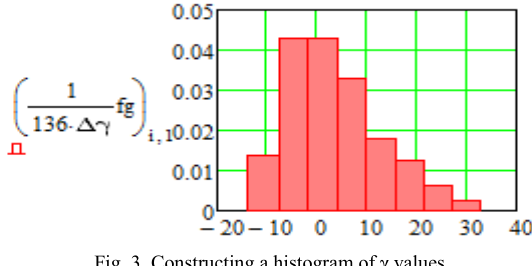
Fig. 3. Constructing a histogram of γ values.